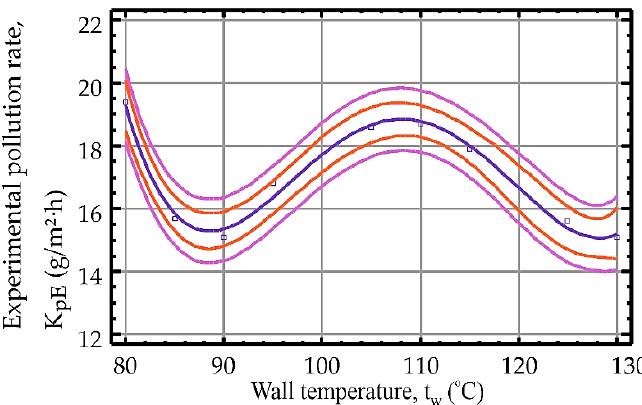
Figure 7. Experimental dependences of pollution rate K pE on wall temperature t w with confidence and prediction curves during the fuel oils combustion.